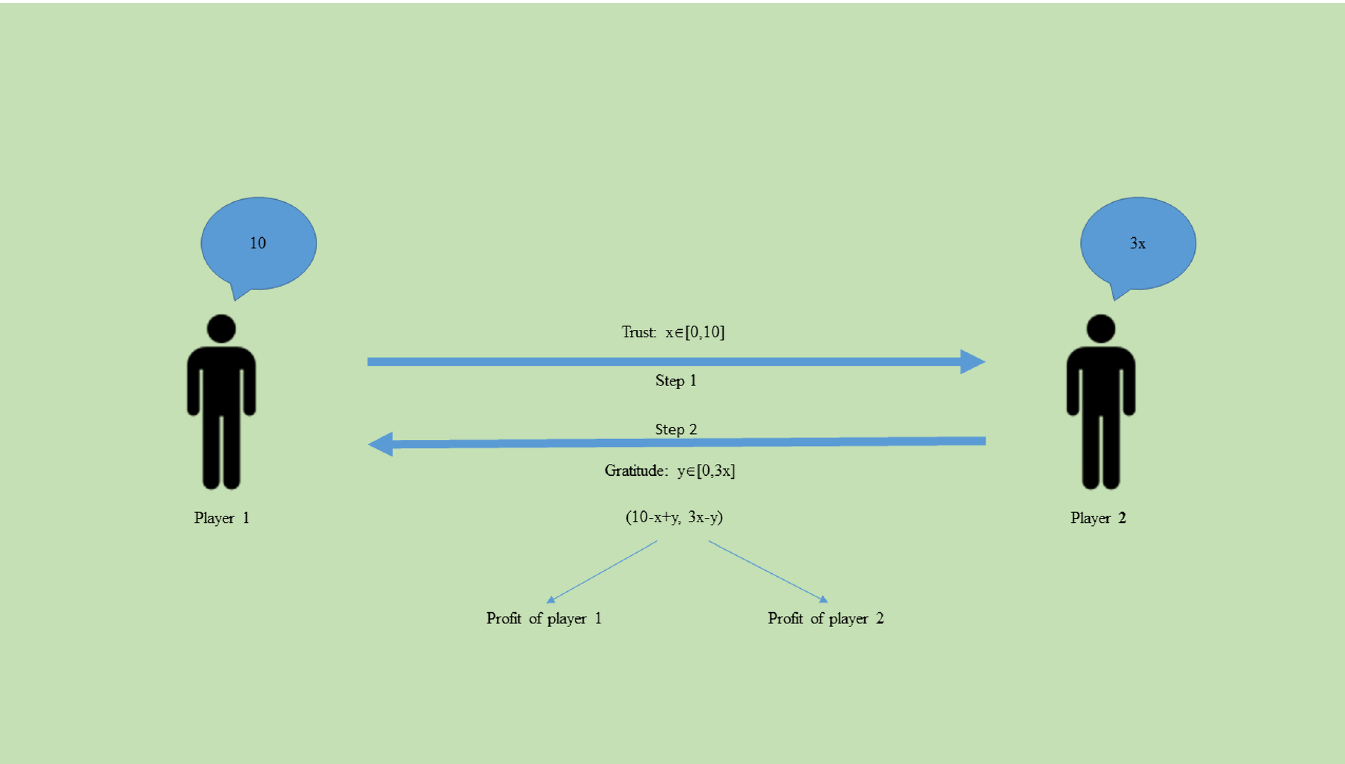
Fig 1. The structure of the Trust Game. The illustrationrepresents the decisionmaking process duringthe TG. Player 1 starts the game and offers some integer number from zero to ten to player 2. Player 2 gets the offered numbermultipliedby three. Then player 2 returns any number of the number available.